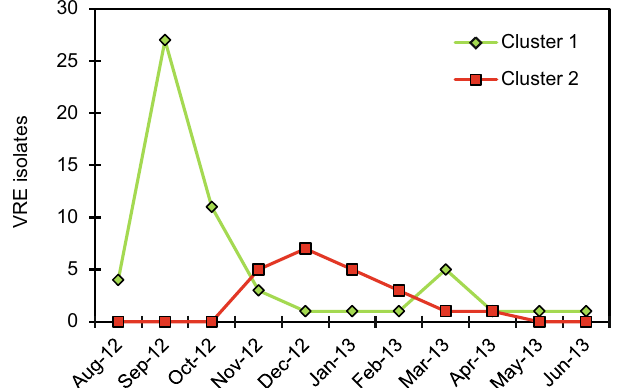
Figure 3. Monthly distribution of cluster 1 and cluster 2 related strains. Strains belonging to cluster 1 (green line) and cluster 2 (red line) are defined by > 88% similarity by PFGE during the outbreak period. Strains unrelated to the two main clusters are not included in the chart. Most of the isolates in cluster 1 were found during screening September and October 2012, concurrent with the decline of positive isolates related to strains in cluster 1, cluster 2 related strains were introduced in November